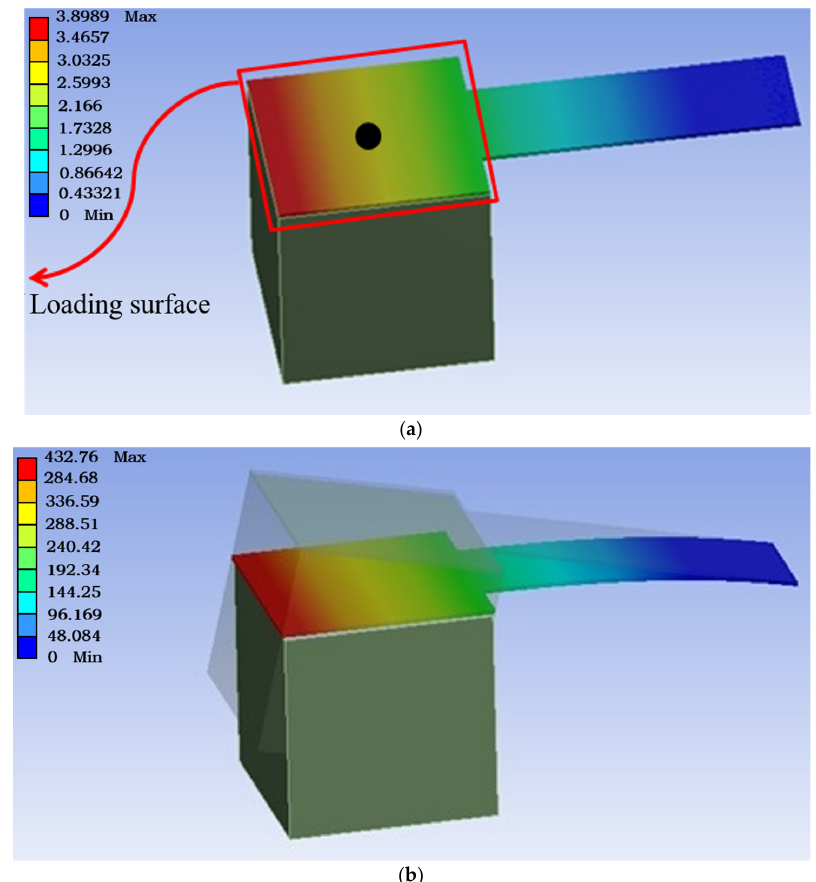
Figure 9. Displacement of the cantilever beam: ( a ) Initial state and ( b ) Vibration of the loading surface loaded with magnetostatic force.